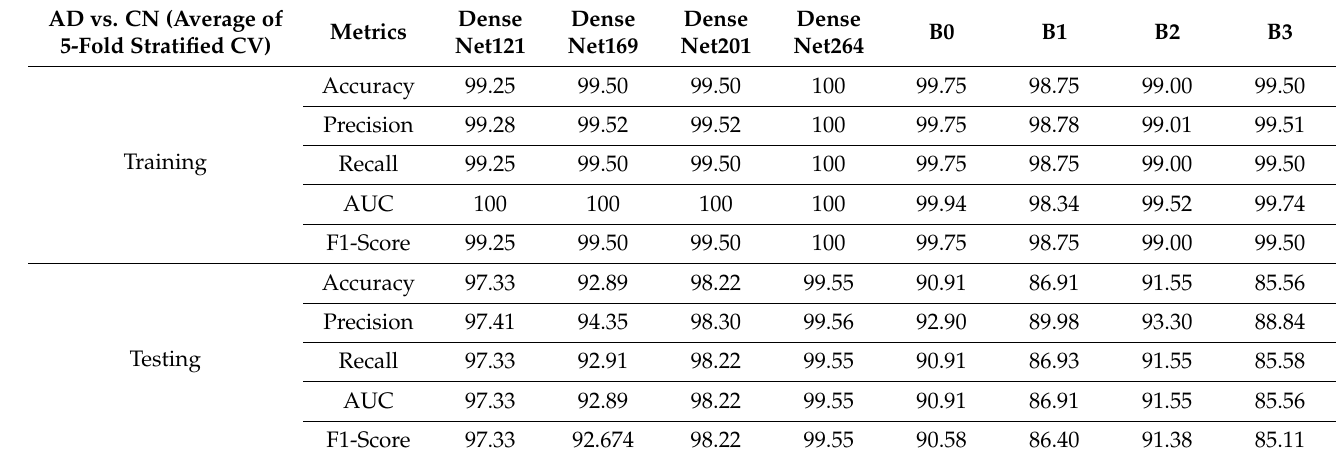
Table 8. The findings of the implemented models for AD vs. CN classification.